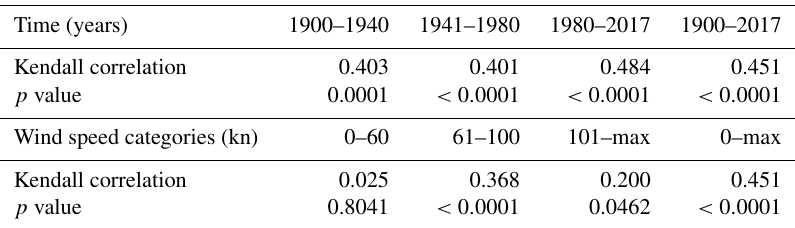
Figure 3. The area of total destruction (ATD) by landfalling state over the periods 1900–1940, 1941–1980 and 1981–2017 indicated by varying symbols and blue and red symbols showing ATD below and above the overall mean ATD respectively. Table 3. Kendall correlation coefficients between the ATD and maximum landfalling wind speed stratified by time period and wind speed category with corresponding p